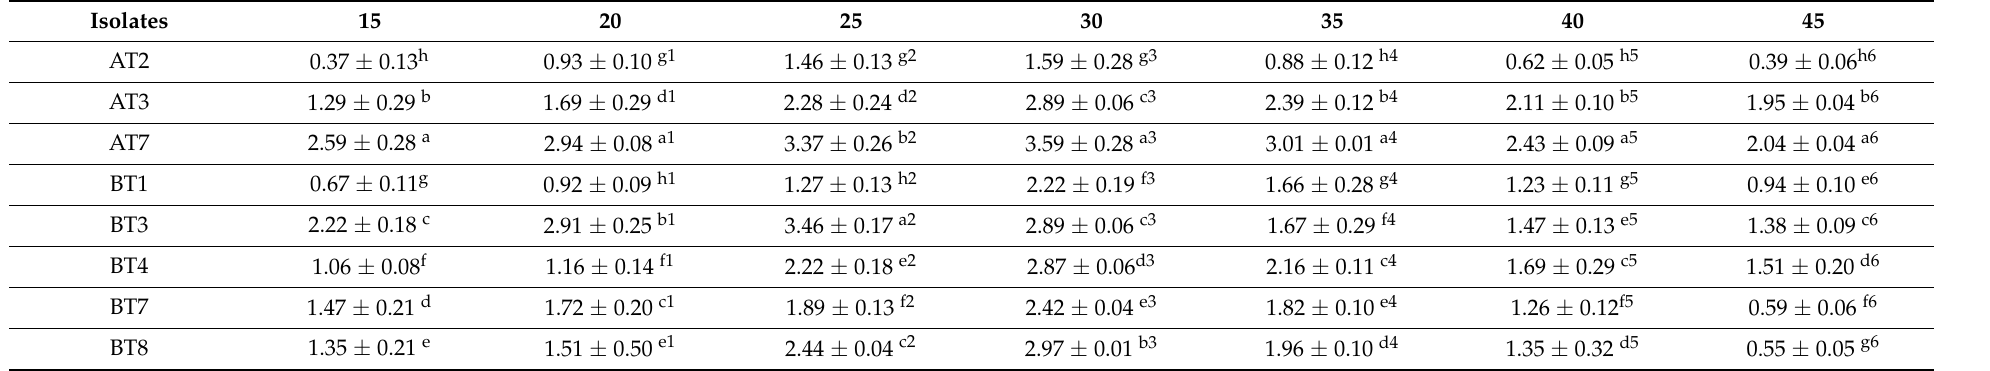
Table 4. Effect of temperature ( ◦ C) on chitinase activity of various Trichoderma